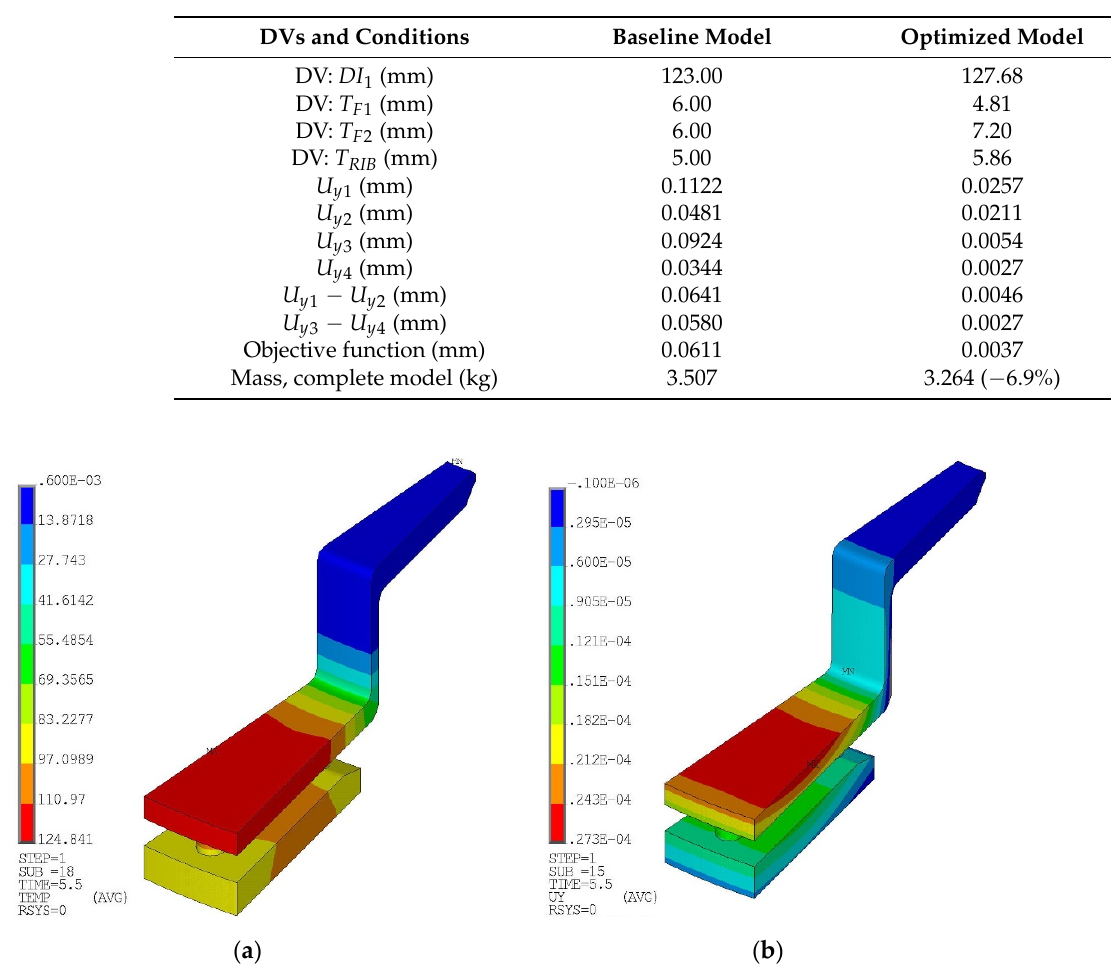
Table 5. Optimization results for Case 2.